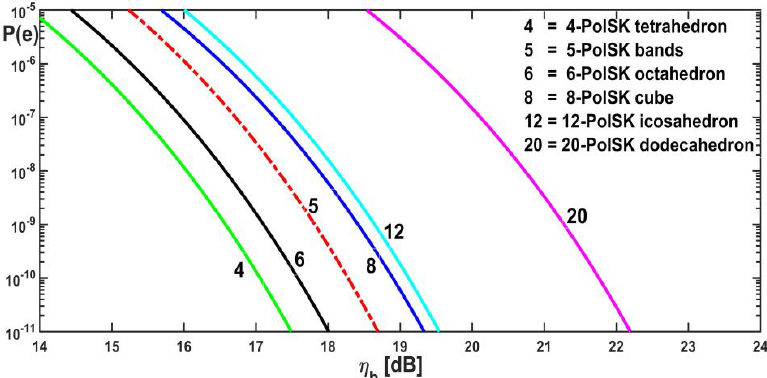
Figure 11. Comparison between Multilevel-Polarization Shift Keying (M-PolSK) [7] and 5-PolSK. The proposed system is located between the 6-PolSK octahedron and 8-PolSK cube curves. It is slightly better (~0.1 dB) than the optimum 8-PolSK non-regular polyhedron described in [7], not reported in Figure 11. The decision regions are calculated by means of a unique angle (colatitude), neglecting the longitudinal one. This choice from one side causes a penalty of less than 1 dB (~0.7 dB) with respect to the 6-PolSK octahedron, but from the other side it guarantees a simpler receiver based